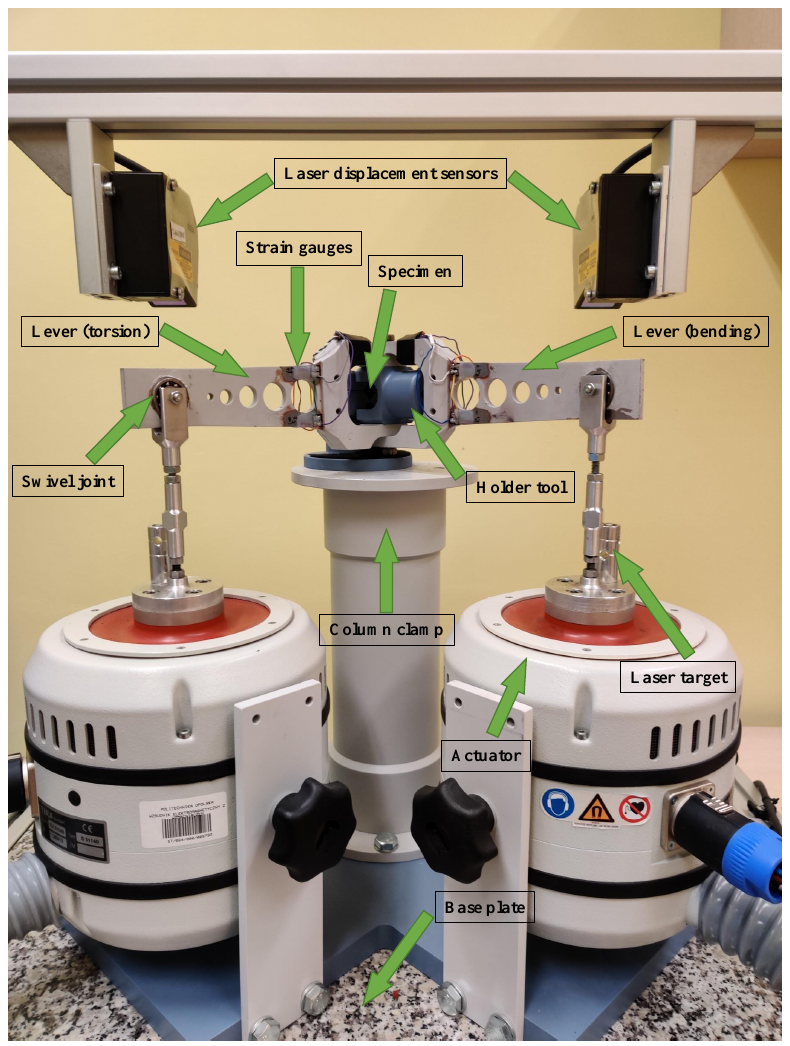
Figure 2. Fatigue testing